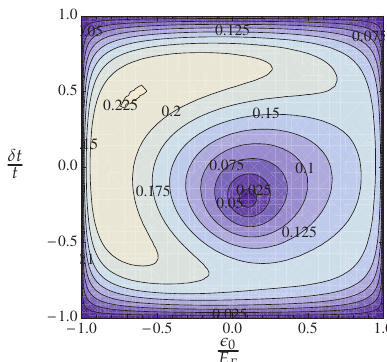
e − (cid:96) ρ ) as a function of the ≡